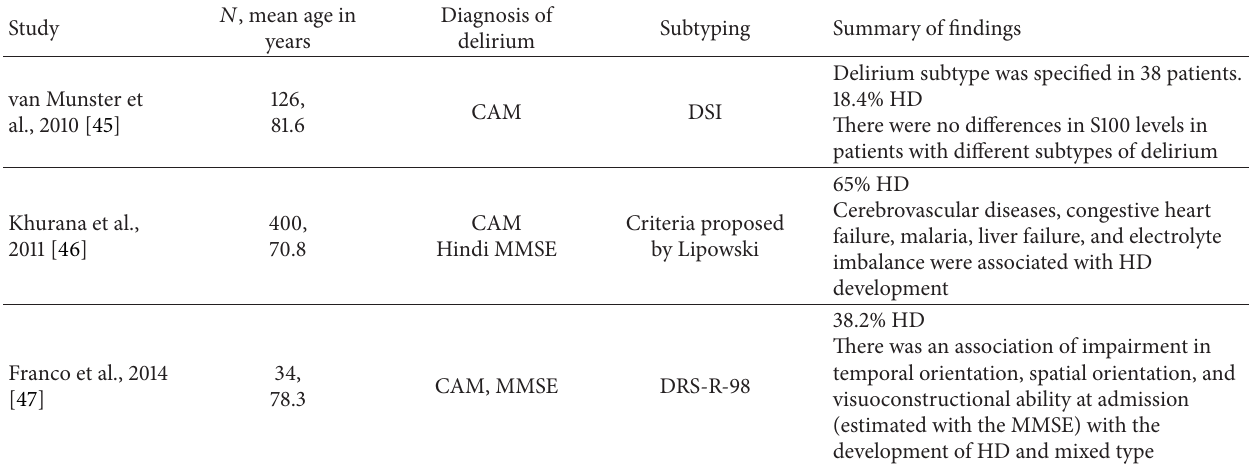
Table 5: HD in internal medicine.